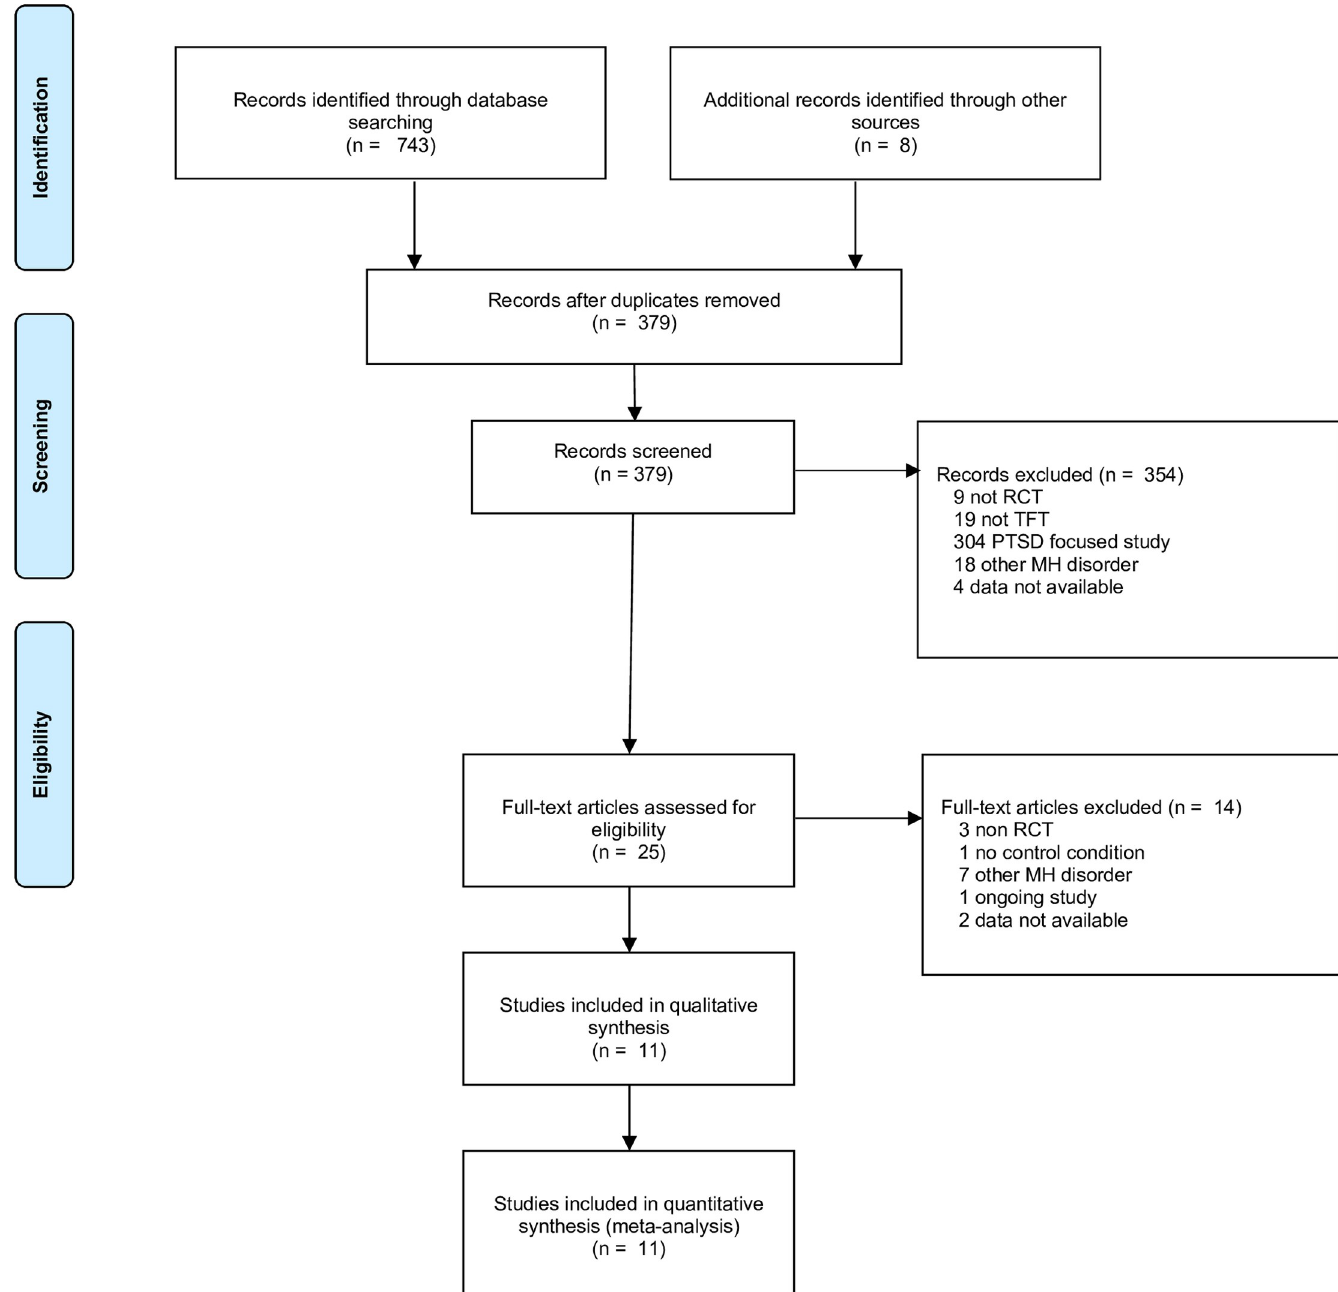
Fig 1. Flow chart of inclusion of trials for the meta-analysis of studies on trauma-focused treatments and depression.